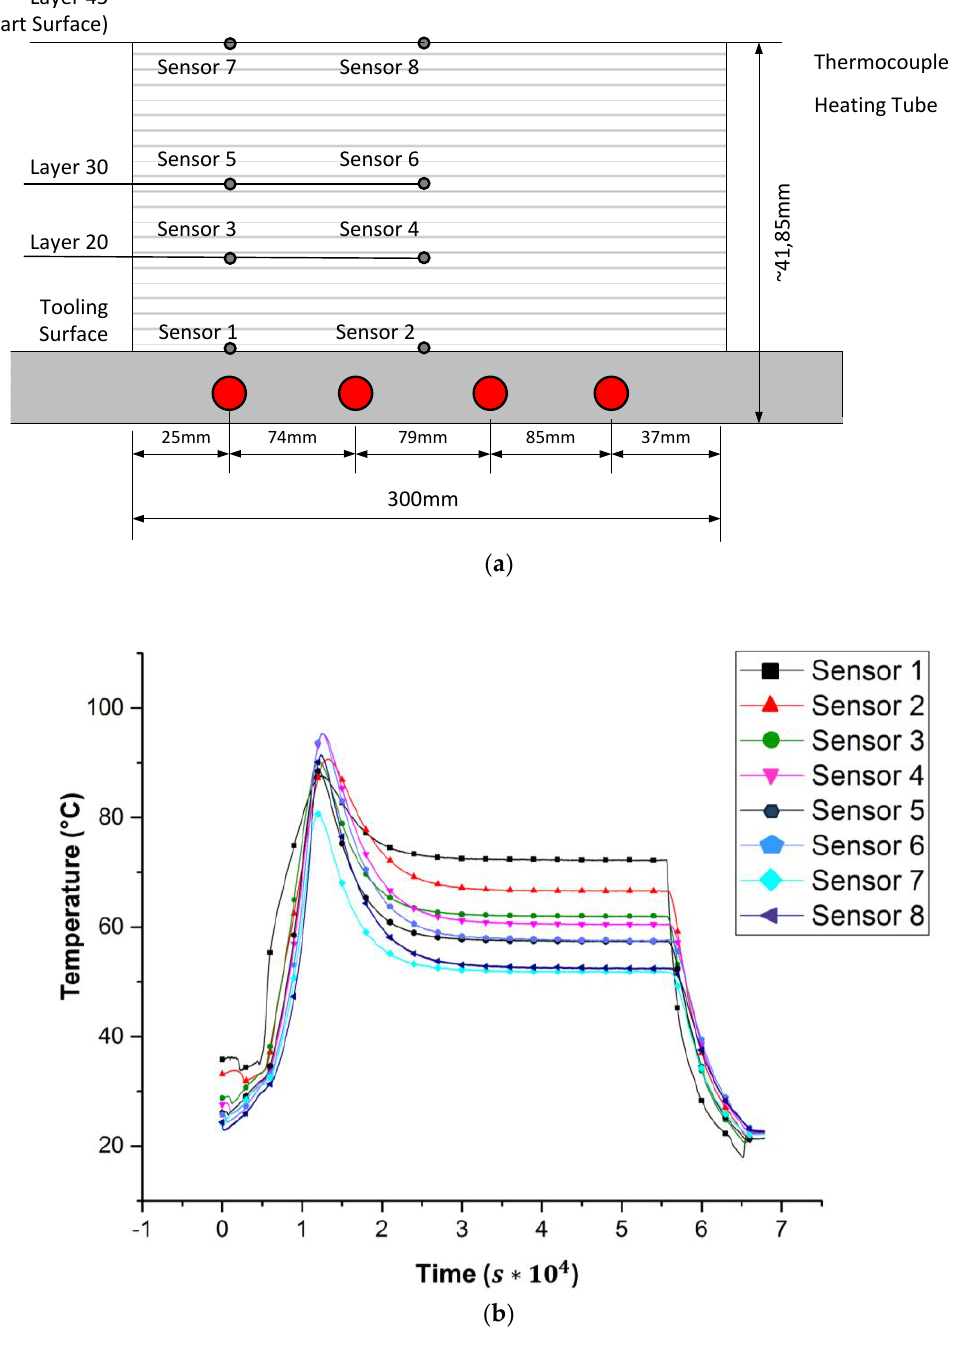
Figure 6. Temperature profiles during the curing process; ( a ) senor position; ( b ) measurement data.